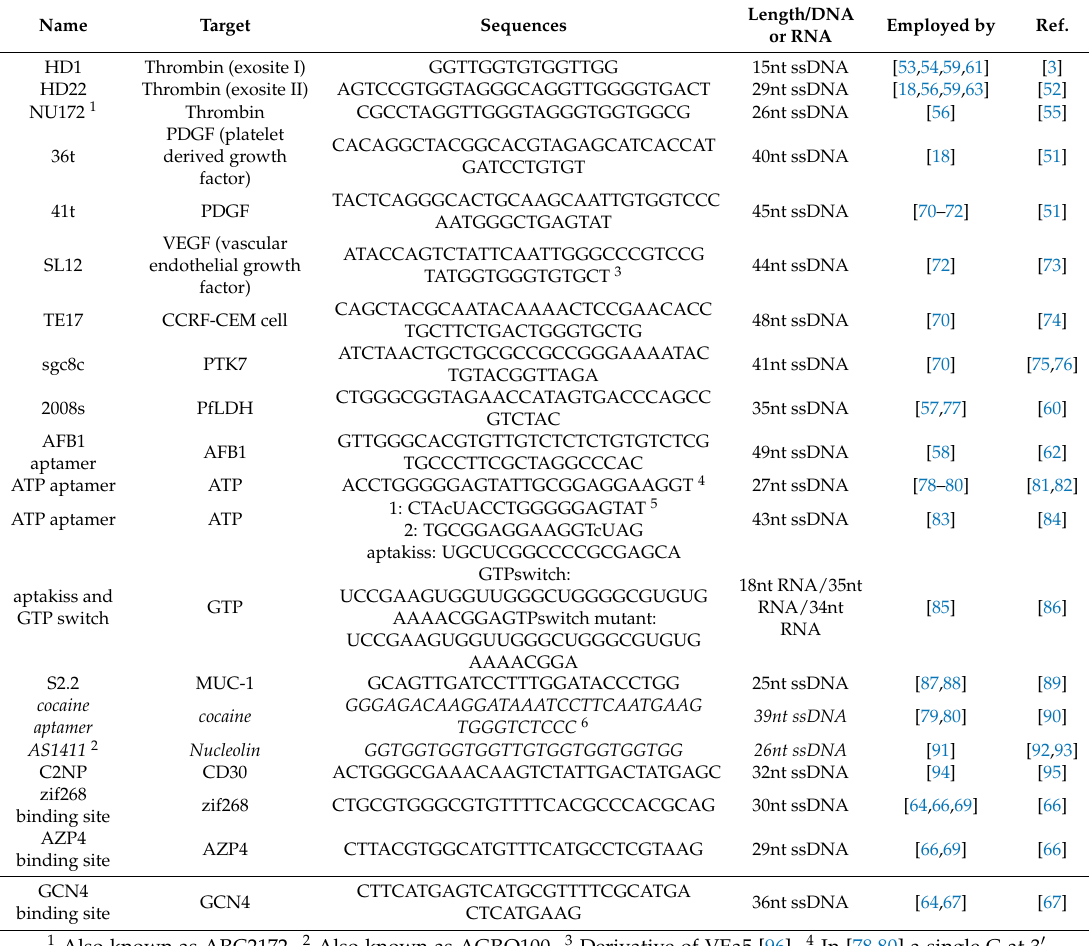
Table 1. Summary of aptamers utilised in DNA origami